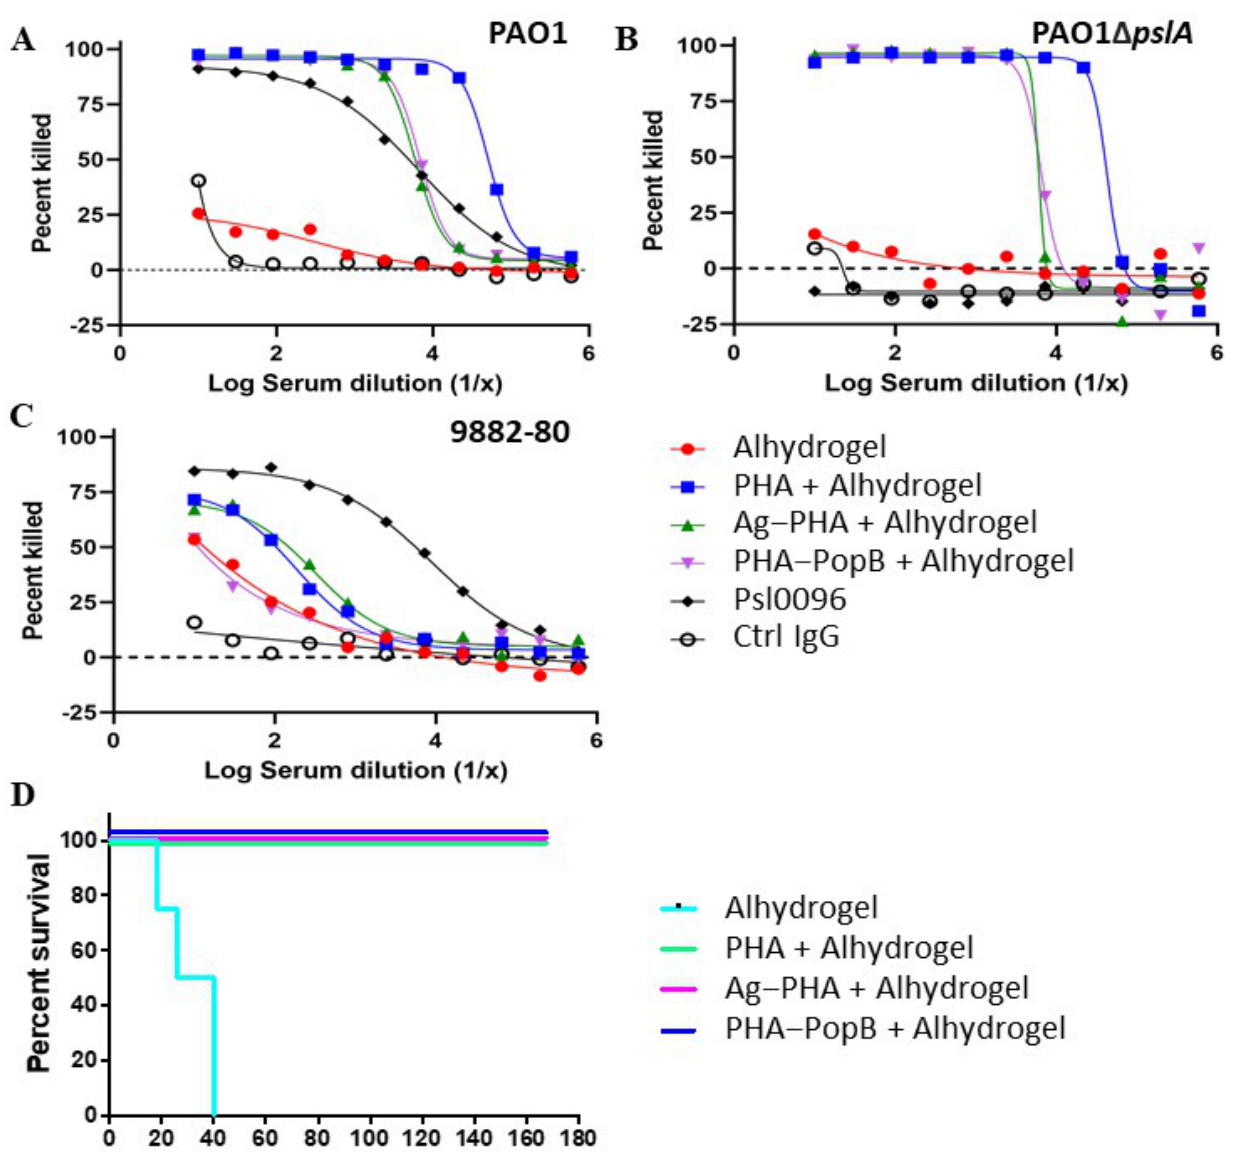
Figure 5. PHA bead vaccines induced functional antibodies and protective immunity. a-c OPK assay against P. aeruginosa ( A ) strain PAO1, ( B ) strain PAO1Δ pslA , and ( C ) serotype O11 strain 9882‐80. Percent killing was calculated relative to results obtained in assays run in the absence of serum/antibody. Results are one representative experiment of three independent experiments performed. ( D ) Survival of the vaccinated FVB/N mice after challenge with the serotype O6 P. aeruginosa strain N13. Mice (n = 12 per group) were immunized SC with Alhydrogel, PHA bead + Alhydrogel, Ag‐PHA bead + Alhydrogel, or PHA‐PopB bead + Alhydrogel, once every 2 weeks for 6 weeks (3 doses), and then intranasally challenged 3 weeks later.